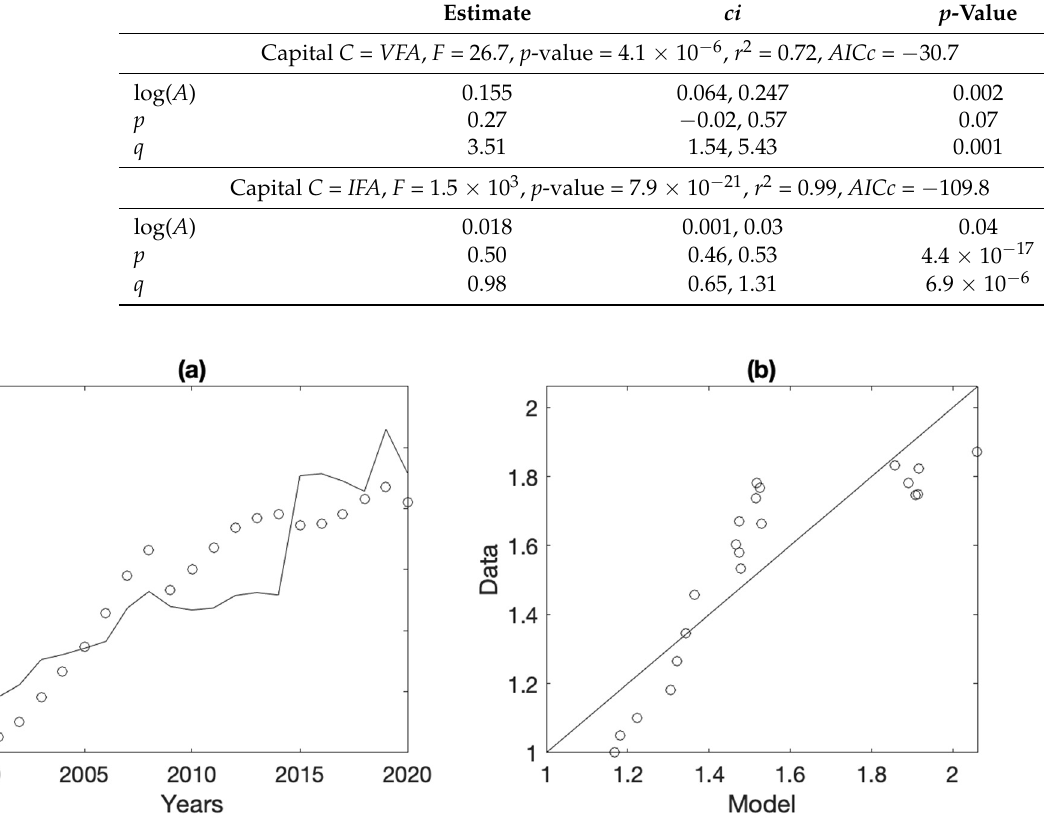
Figure 2. Dynamics of the GDP physical volume index ( a ) and actual data and model values ( b ). Circles denote actual data, black line is values obtained according to the Cobb-Douglas PF (1) with parameters from Table 1, where VFA is taken as the capital C .